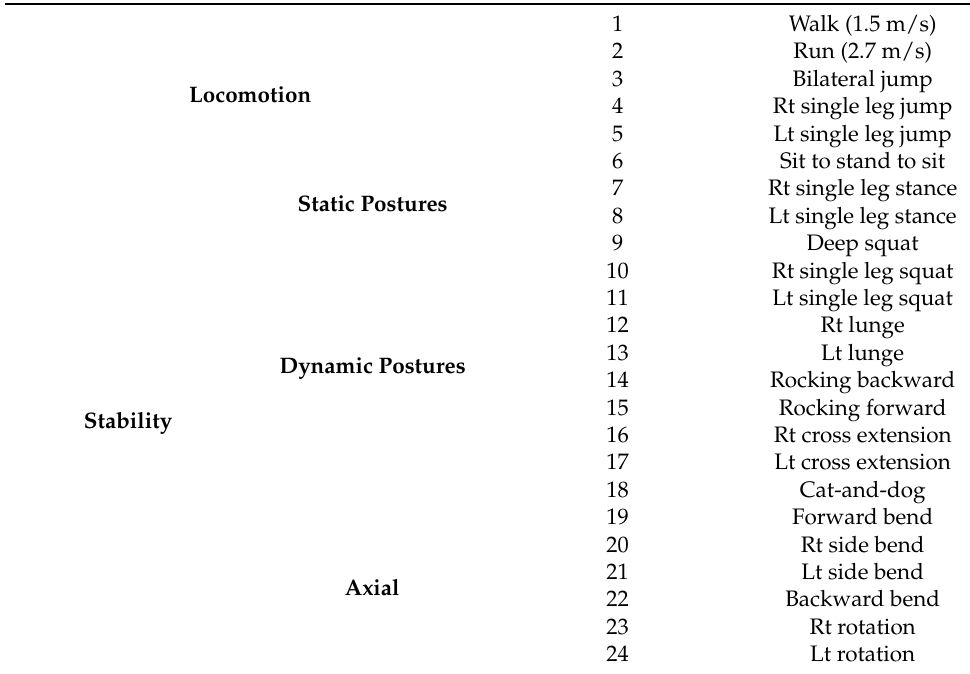
Table 1. Movement and postural